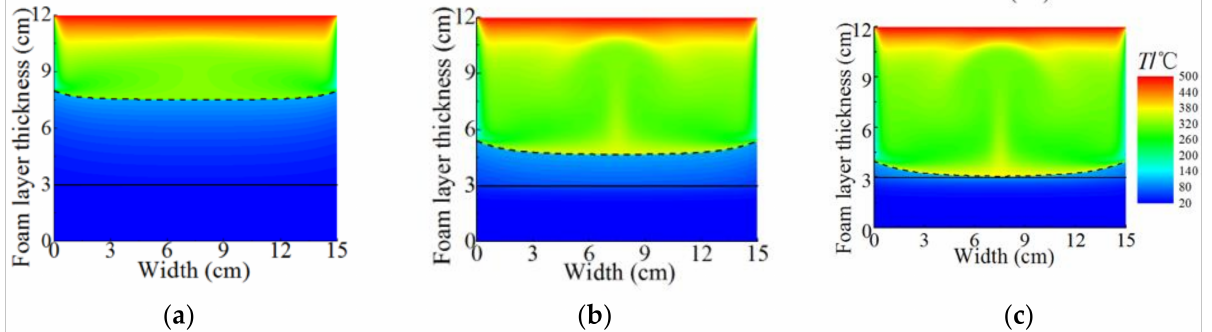
Figure 4. Temperature contour at different heating times under the typical heating conditions at different heating times. ( a ) t = 5 min, ( b ) t = 10 min, and ( c ) t = 13.31 min. The dotted line represents the upper surface of the gel foam